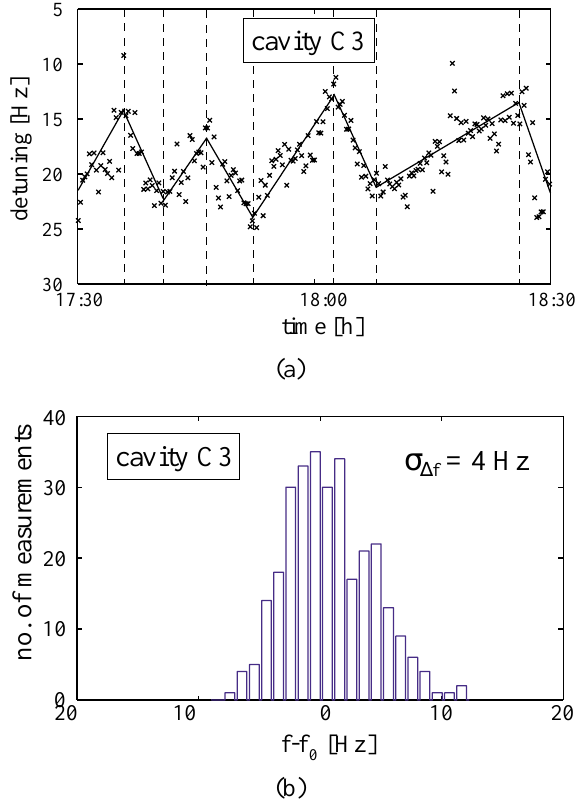
FIG. 25. Fluctuations of the cavity resonance frequency. (a) Slow drifts caused by helium pressure variations. The sensitivity is 10 Hz (cid:1) mbar. (b) Random variations of resonance frequency after correction for the slow